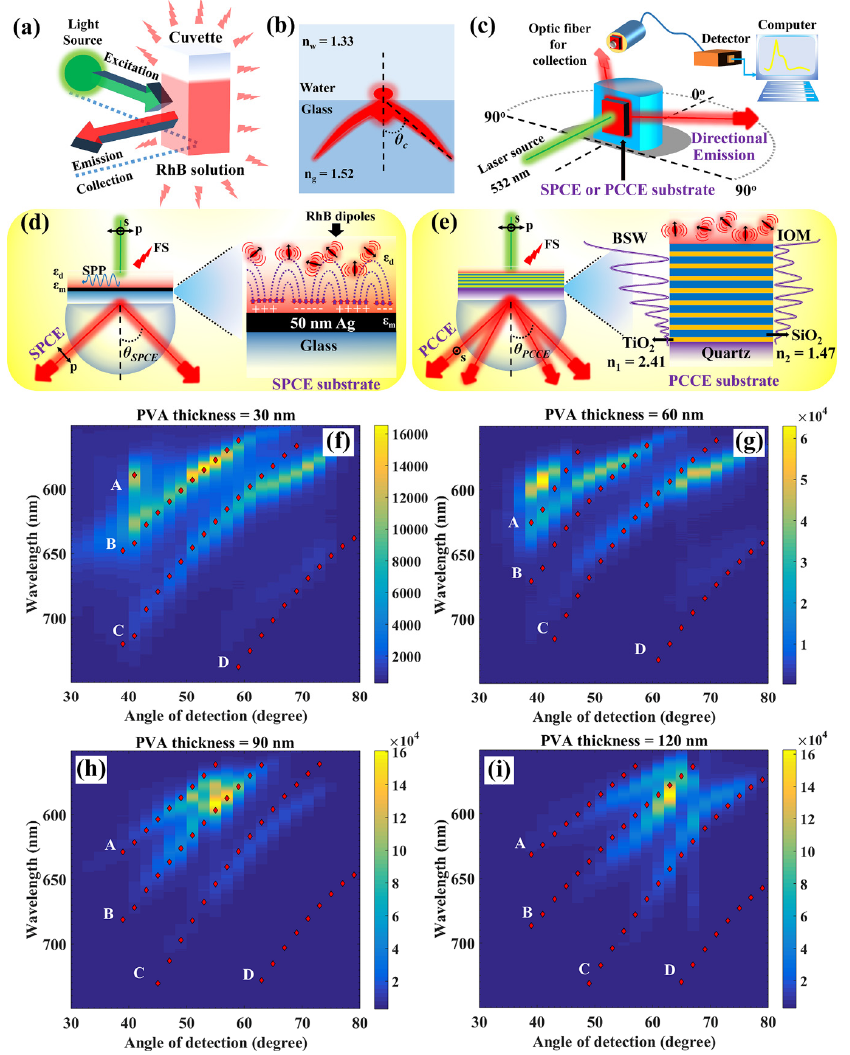
Figure 10. Conceptual schematic of ( a ) fluorescence emission (of RhB) recorded in conventional fluorescence spectrophotometer, ( b ) the angular dispersion of fluorescence emission as observed in the water–glass interface. The angle shown is the critical angle ( θ C ) of emission. ( c ) The optical setup used for SPCE experimental work with reverse Kretschmann (RK) configuration. Adapted with permission from [44]. Conceptual schematic of coupling of emission with ( d ) propagating surface plasmon polaritons (SPPs) of the metal thin film (with θ SPCE as the angle of emission) and ( e ) surface ‐ trapped modes of 1DPC (with θ PCCE as the angle of emission). The magnified images on the right side of ( d , e ) display the coupling at the nanointerface. Adapted with permission from [44]. PCCE for the 1DPC ‐ PVA ‐ XX structure with XX (nm thickness) as ( f ) 30, ( g ) 60, ( h ) 90, and ( i ) 120 under 532 nm excitation. The color bar represents fluorescence intensity in arbitrary units. The red dots present the locations of BSW and IOMs from the numerically calculated dispersion diagram. Adapted with permission from [43].